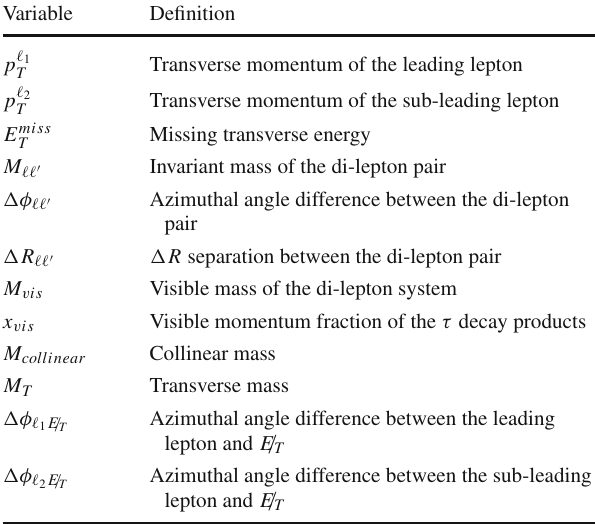
relevant observables and their definitions are listed in Table